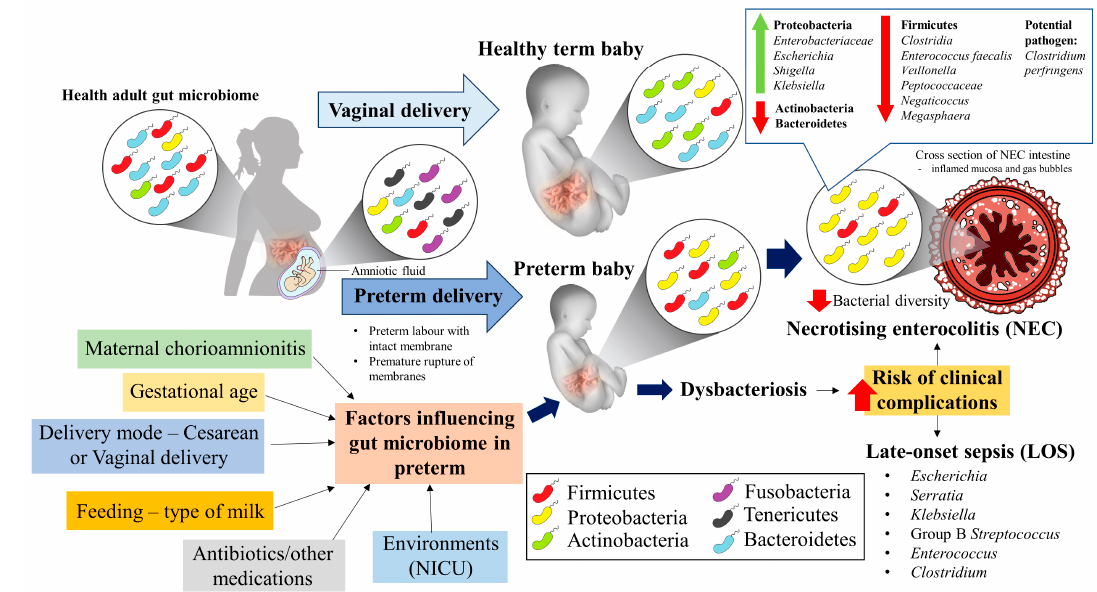
Figure 1. A graphical abstract illustrates the associations between the gut microbiome of preterm infants alone or in combination with postnatal gut dysbacteriosis and the predisposition to NEC and LONS.